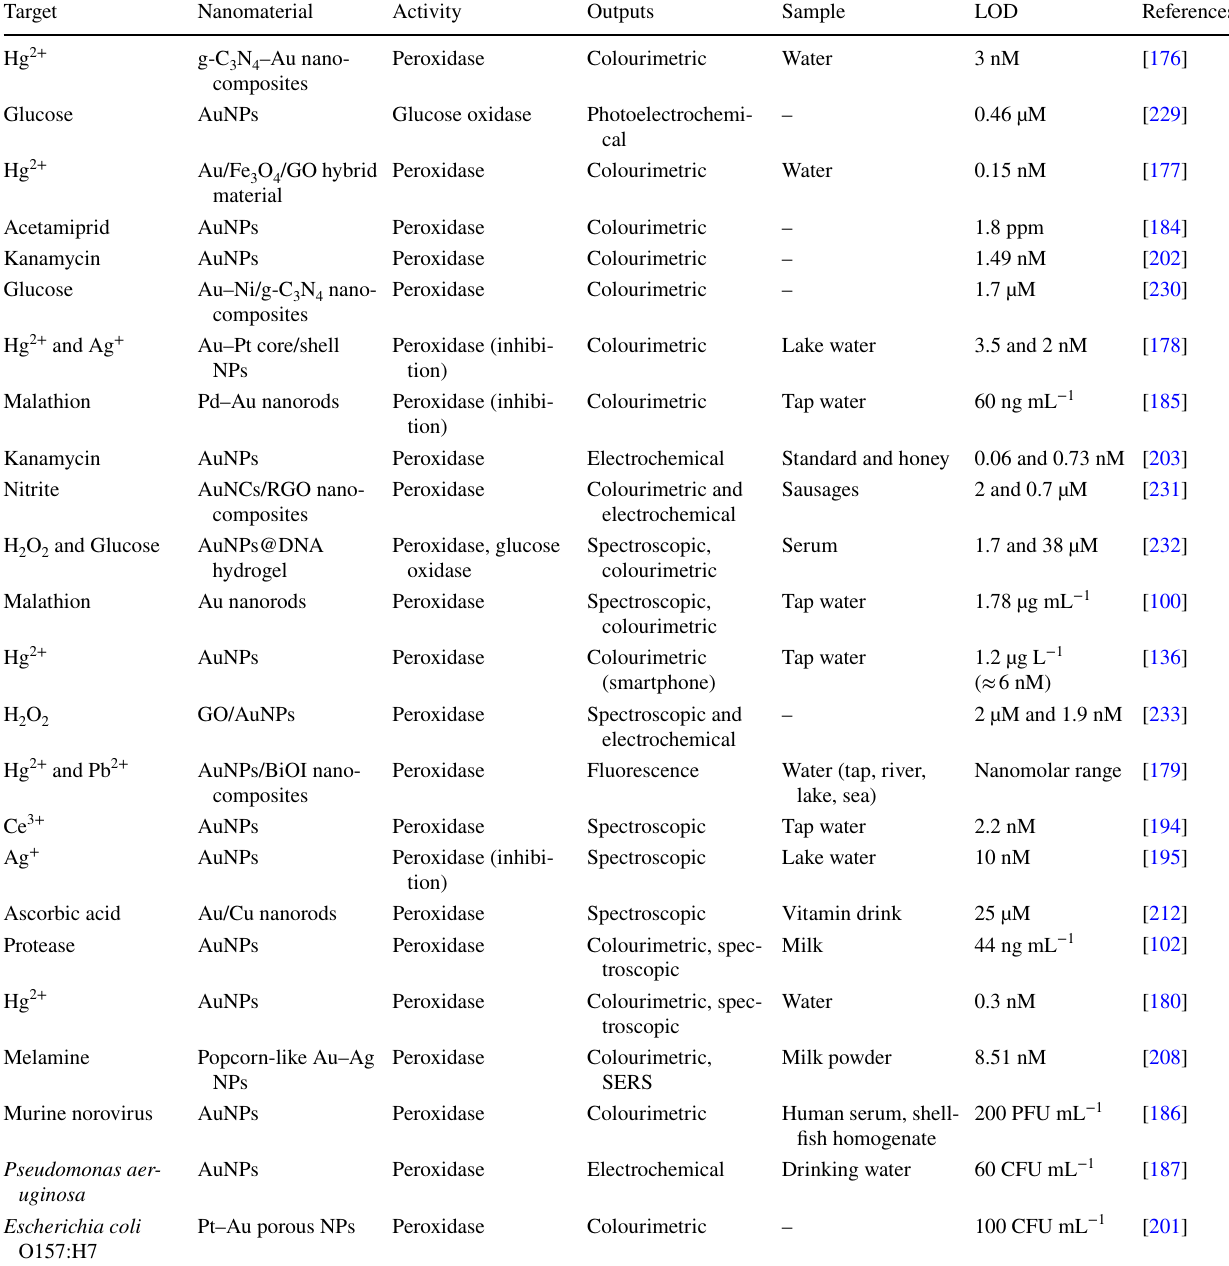
Table 2 Other non‑clinical biosensors relate the use of the catalytic properties of gold nanomaterials